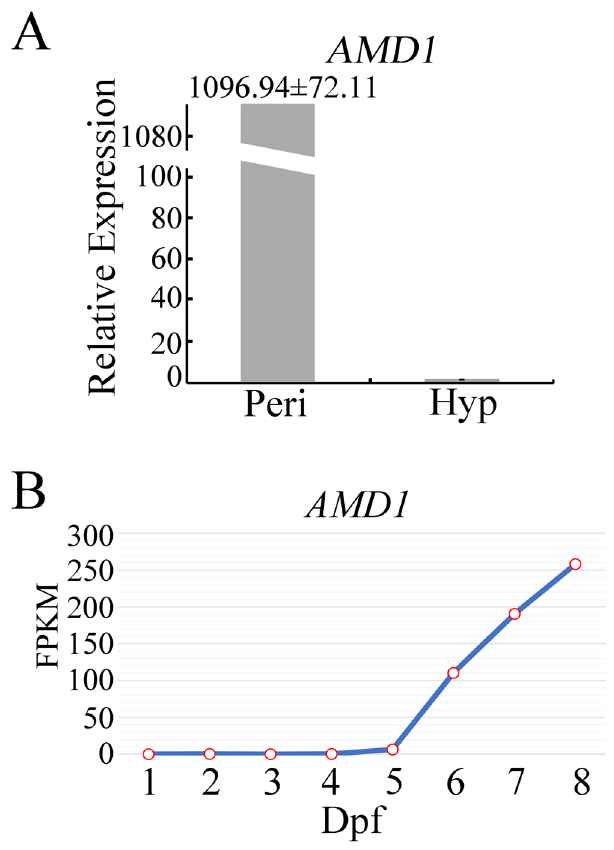
Figure 2. Expression of AMD1 in late stages of sexual development. (A) The expression level of AMD1 transcripts was assayed by qRT-PCR with RNA isolated from 12 h YEPD cultures (Hyp; arbitrarily set to 1) and 8 days post-fertilization (dpf) perithecia (Peri). Mean and standard deviation were calculated with data from three independent replicates. ( B ) The abundance of AMD1 transcripts in different sexual stages based on RNA-seq data of mating cultures collected at 1–2 dpf and perithecia sampled at 3–8 dpf. FPKM: Fragments Per Kilobase of exon per Million fragments mapped.